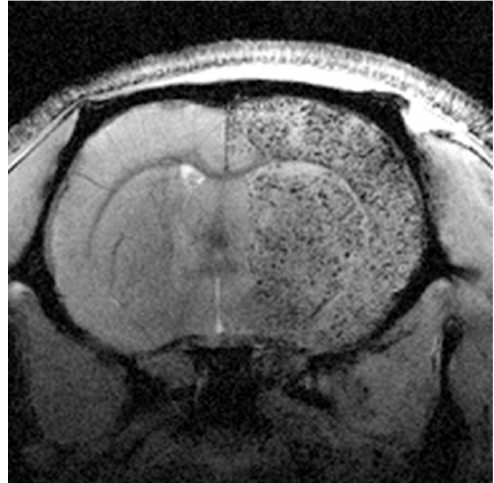
Figure 11. Magnetic resonance image (MRI) of a rat brain slice, 4 h after intraarterial administration of mesenchymal stem cells (MSCs) labeled with magnetic particles. Labeled cells can be observed as black punctate patterns in the right brain hemisphere. Reproduced with permission from [97], SpringerNature, 2017.